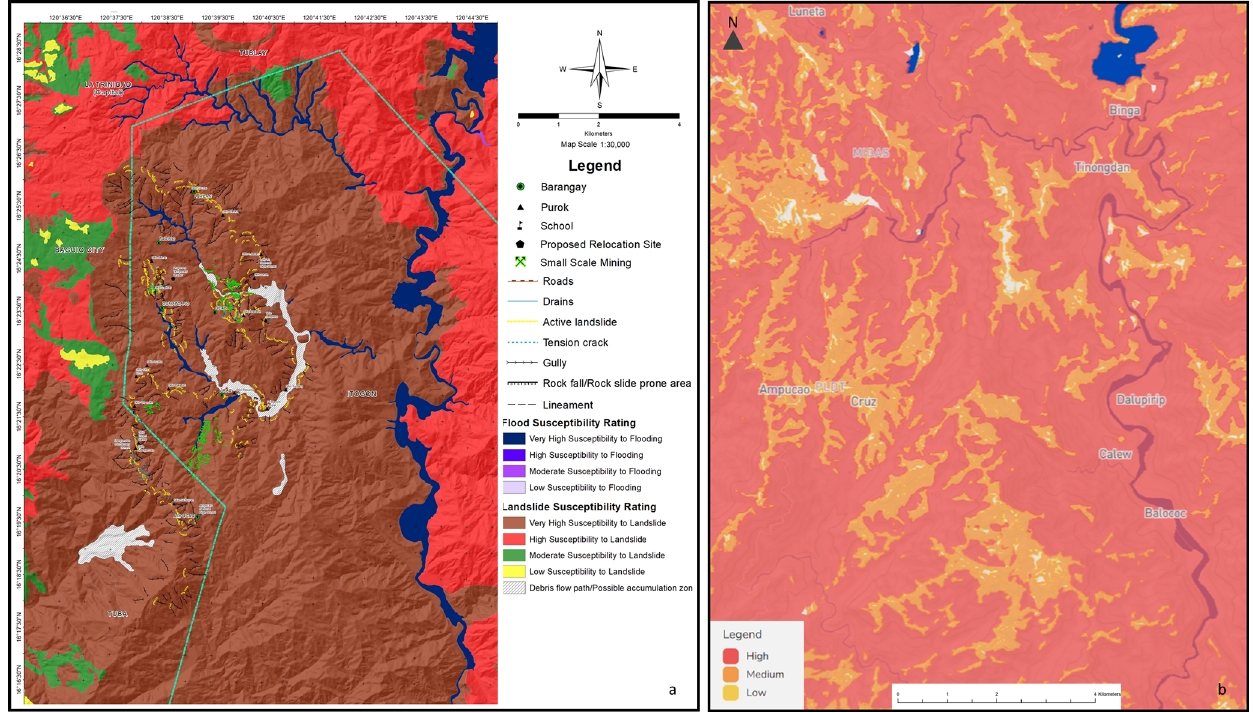
Figure 1. (a) Current landslide susceptibility map of the Itogon region held by the Philippines Mines and Geosciences Bureau (Mines and Geosciences Bureau, MGB, 2018). (b) Sample landslide hazard map from the NOAH National Operational Assessment of Hazards Portal for the same approximate region of Benguet as shown in (a)